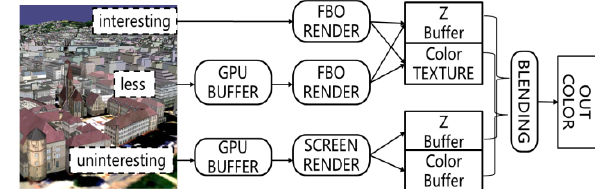
Figure 1: The overview of our